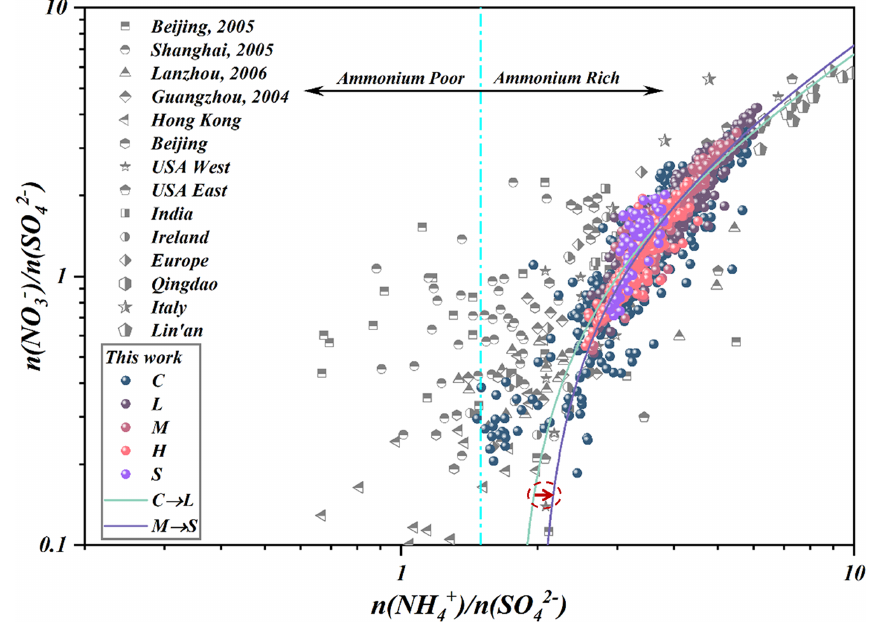
Figure 2. Nitrate to sulfate molar ratio as a function of ammonium to sulfate molar ratio.